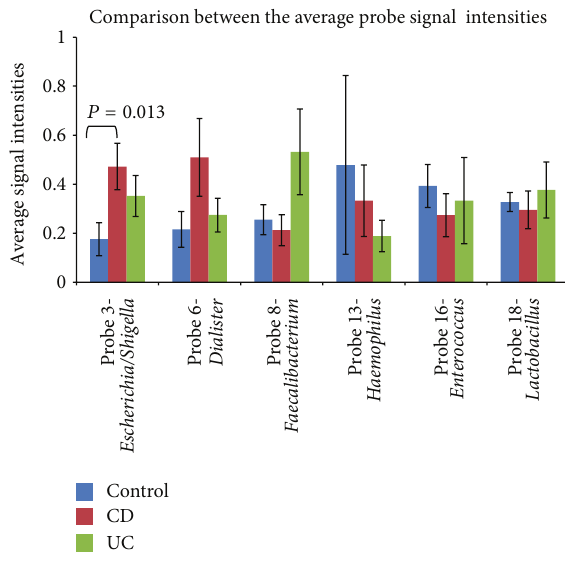
Figure 4: Comparison of the average amount of each component in the three disease states. The averages are calculated based on MCR analysis of stool samples from 33 subjects in the control group, 30 subjects diagnosed with CD (Crohn’s Disease), and 33 subjects diagnosedwithUC(UlcerativeColitis).Standarderrorofarithmetic mean is shown. The significance of the differences between the averages of the three groups, control, CD, and UC, was tested using the t -test where the statistical significance was accepted at 𝑃 < 0.05 . Only the statistically significant 𝑃 values are shown in the figure.